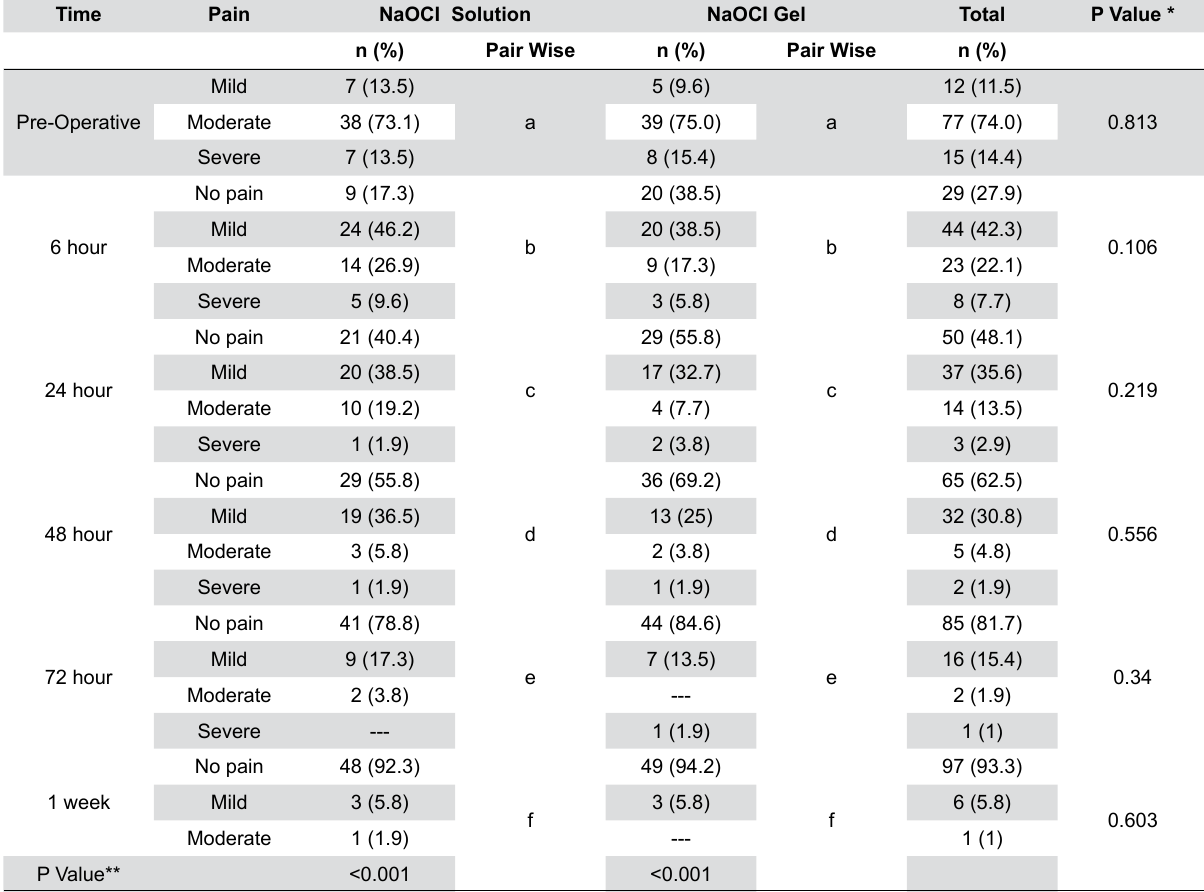
Table 2- Comparison of Pain Levels Between Groups and Within Groups